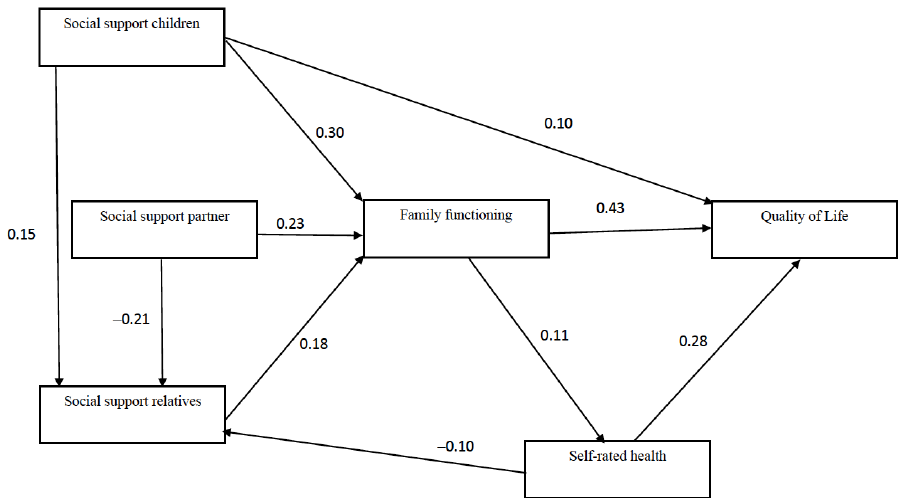
Figure 2. Model fitted for the whole sample. Standardized coefficients.